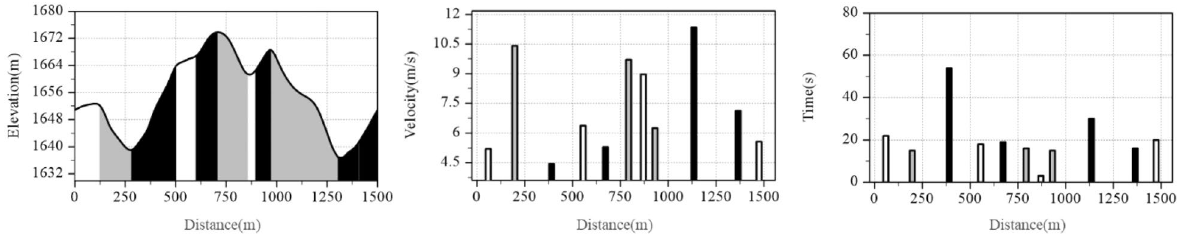
Figure 3. Terrain of Guyangshu track, velocity and time distribution of athlete A.